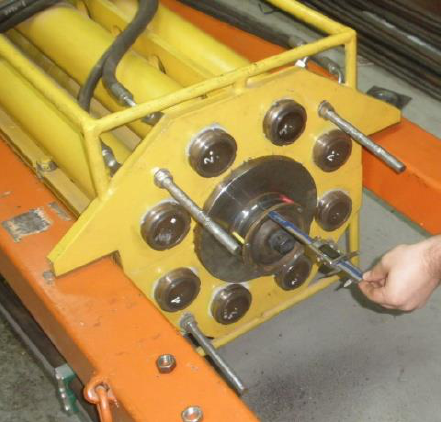
Figure 8. Sensor calibration. Figure 8. Sensor